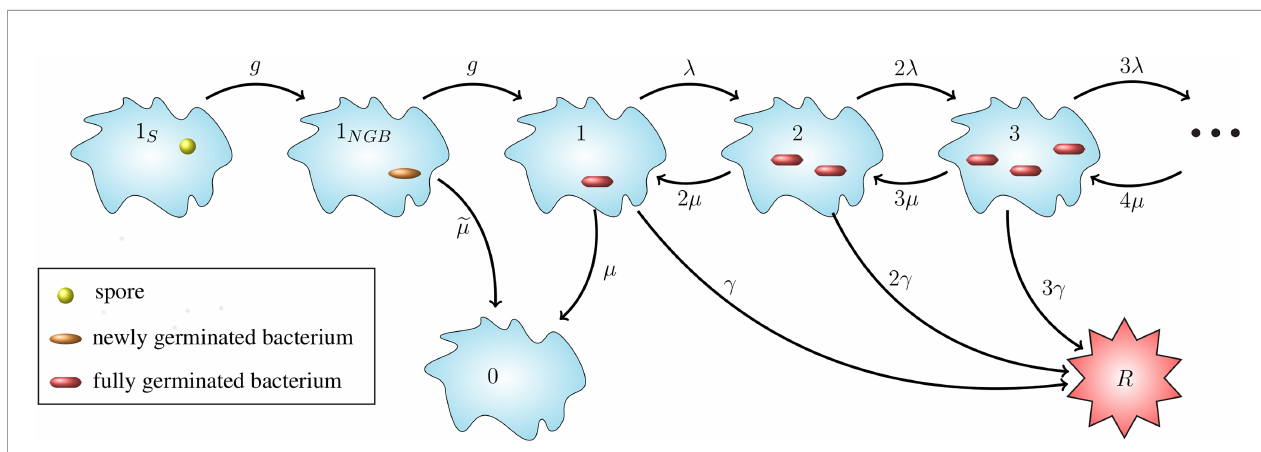
FIGURE 1 | Intracellular infection model. State 1 S represents a phagocytosed spore and state 1 NGB a newly germinated bacterium (NGB). The germination rate from spore to NGB, and also the maturation rate from NGB to vegetative bacterium for a given spore is denoted by g hours -1 , which leads to an Erlang(2, g ) distribution for the germination-maturation time. The rate g is assumed to vary between spores. The death rate of the newly germinated bacterium is given by ~ m hours − 1 . States i ∈ N ∪ {0} represent i intracellular bacteria. State 0 represents recovery and state R the rupture of the cell. 0 and R are absorbing states for the stochastic process. Transitions between states i ∈ N represent three types of events: transition to state i + 1 (division of a bacterium), to state i - 1 (death of a bacterium), and to state R (rupture of the host cell with release of i bacteria). The per bacterium division, death, and rupture rates are l > 0, µ > 0 and g > 0, respectively, all with units ( bacteria · hours ) -1 , leading to a linear birth-and-death process with catastrophe. The infected cell survives for as long as it does not reach state R